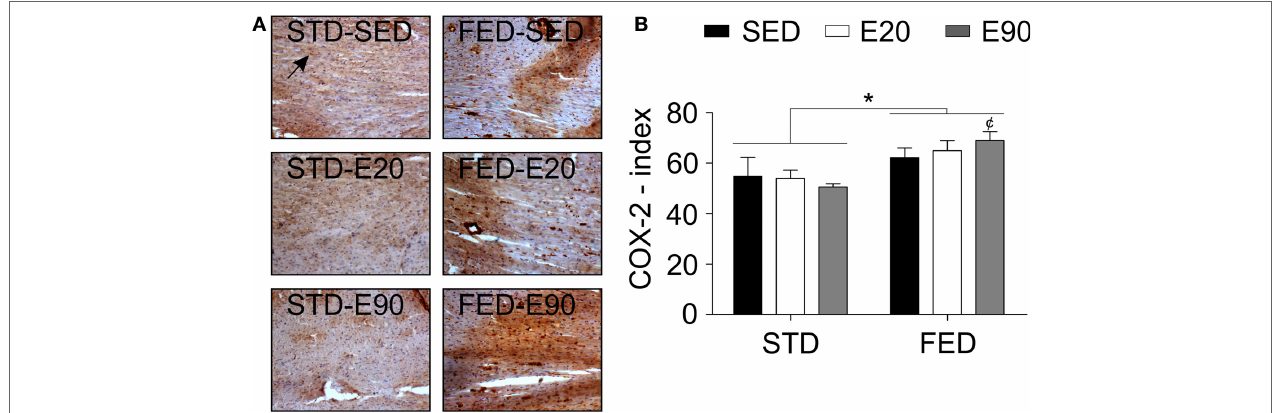
FigUre 4 | a fat-enriched diet promotes inflammation in the heart . (a) Representative pictures illustrate reactions with an anti-cyclooxygenase-2 (COX-2) antibody for each experimental group in heart samples. A black arrow shows a positively stained cell with that anti-COX-2 antibody. Sedentary rats were given a regular chow [standard diet (STD)-SED]; exercised rats were fed a regular chow (STD-E60); sedentary rats were given an HFD (HFD-SED); and exercised rats were fed an HFD (HFD-E60). (B) The COX-2 index was determined to be the number of positive cells per area (square millimeter). Statistical Analysis I: ¢ p < 0.05 vs. FED-SED. Statistical Analysis II: * p < 0.05. Data analysis: two-way ANOVA test (Bonferroni’s post hoc test). Reported values are the mean ±